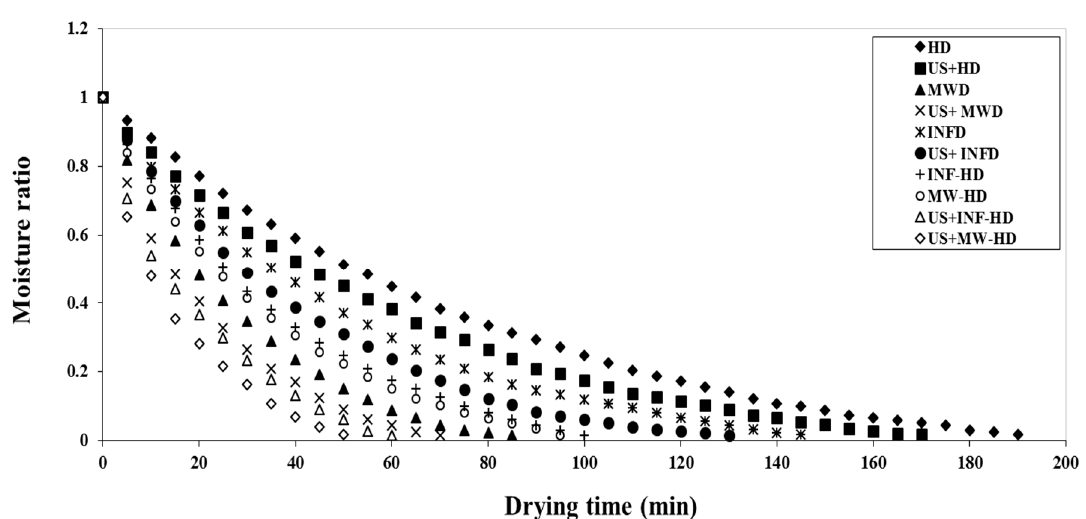
Figure 1. Drying kinetic of the carrot samples pretreated with ultrasound in different drying methods.